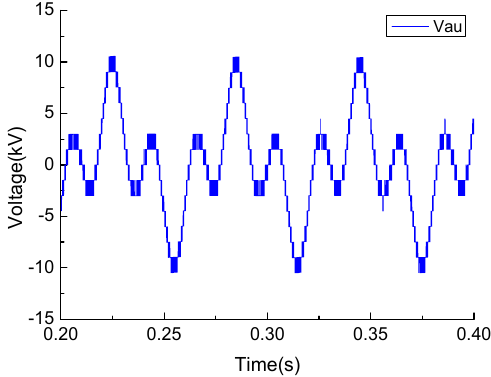
Figure 4. Module voltage waveform of branch-au.